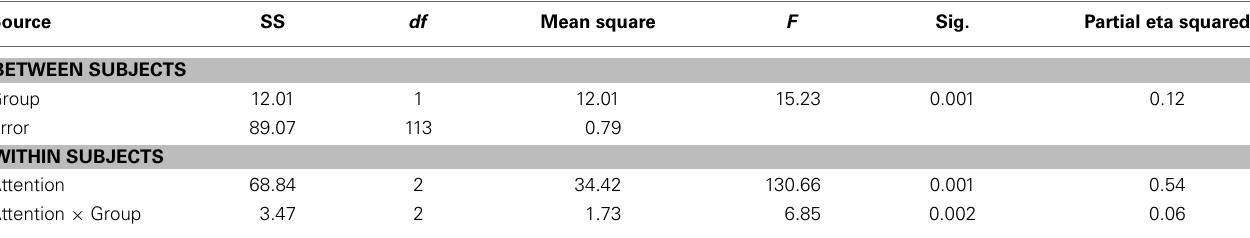
Table 3 | Summary of analysis of variance of performance scores on group (Dyslexia vs. Normal control), and attention (Easy vs. Difficult vs.